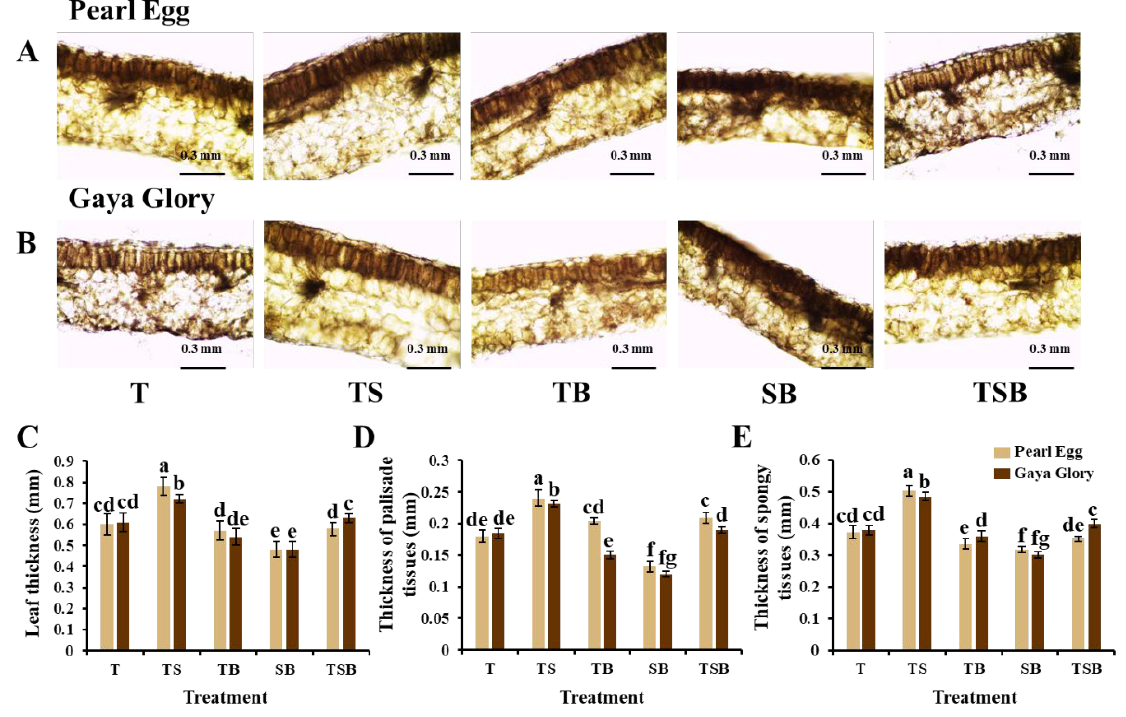
Figure 3. Changes in the leaf structure of chrysanthemum “Pearl Egg” and “Gaya Glory” plants as affected by the different lighting direction combinations. The leaf structure ( A , B ); the thickness of leaves, palisade tissues, and spongy tissues ( C – E ). T, TS, TB, SB, and TSB, refer to top (1/1), top (1/2) + side (1/2), top (1/2) + bottom (1/2), side (1/2) + bottom (1/2), and top (1/3) + side (1/3) + bottom (1/3) lighting, respectively. Vertical bars indicate the means ± standard error ( n = 6). Different lowercase letters indicate significant separation within treatments by Duncan’s multiple range test at p ≤ 0.05. Bars indicate 0.3